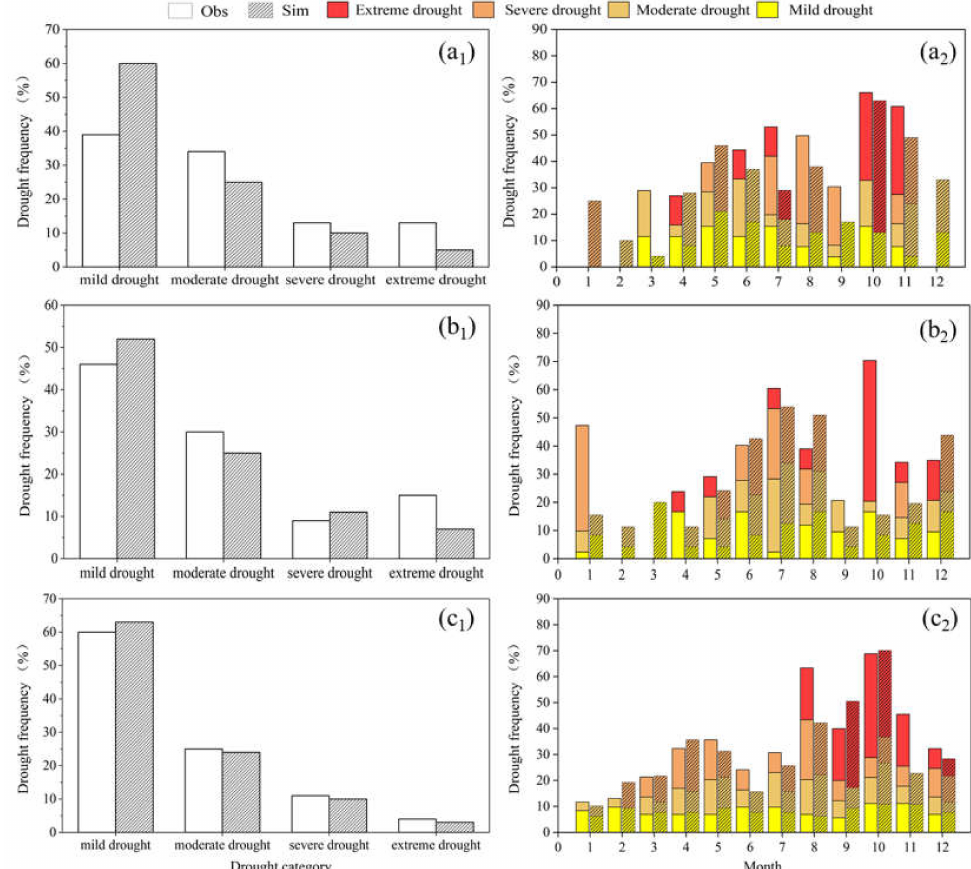
Figure 7. Drought frequency based on observed and simulated runoff during the impact pe- riod. ( a 1 ) Different levels of drought on SRI 1 ; ( a 2 ) different levels of drought by month on SRI 1 ; ( b 1 ) different levels of drought on SRI 3 ; ( b 2 ) different levels of drought by month on SRI 3 ; ( c 1 ) different levels of drought on SRI1 2 ; ( c 2 ) different levels of drought by month on SRI 12